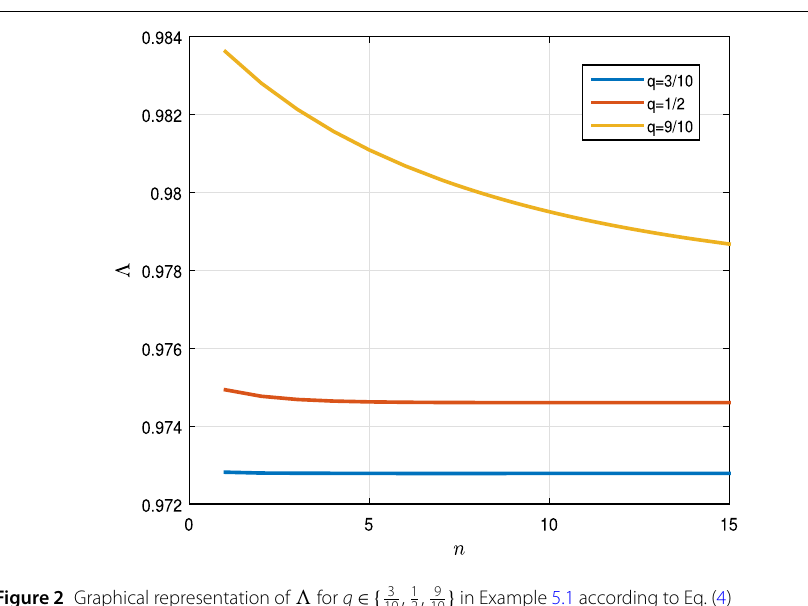
Figure 2 Graphical representation of (cid:18) for q ∈ { 3